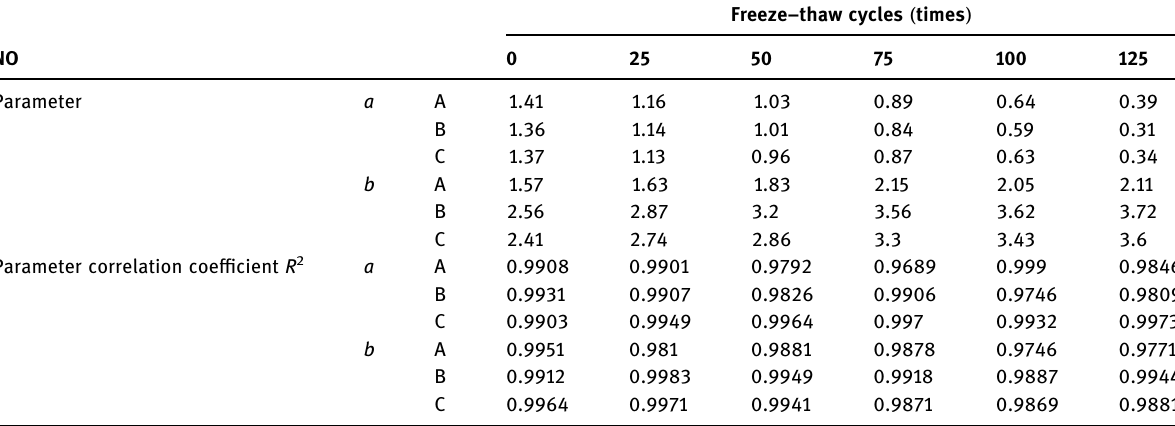
Freeze – thaw cycles ( times )